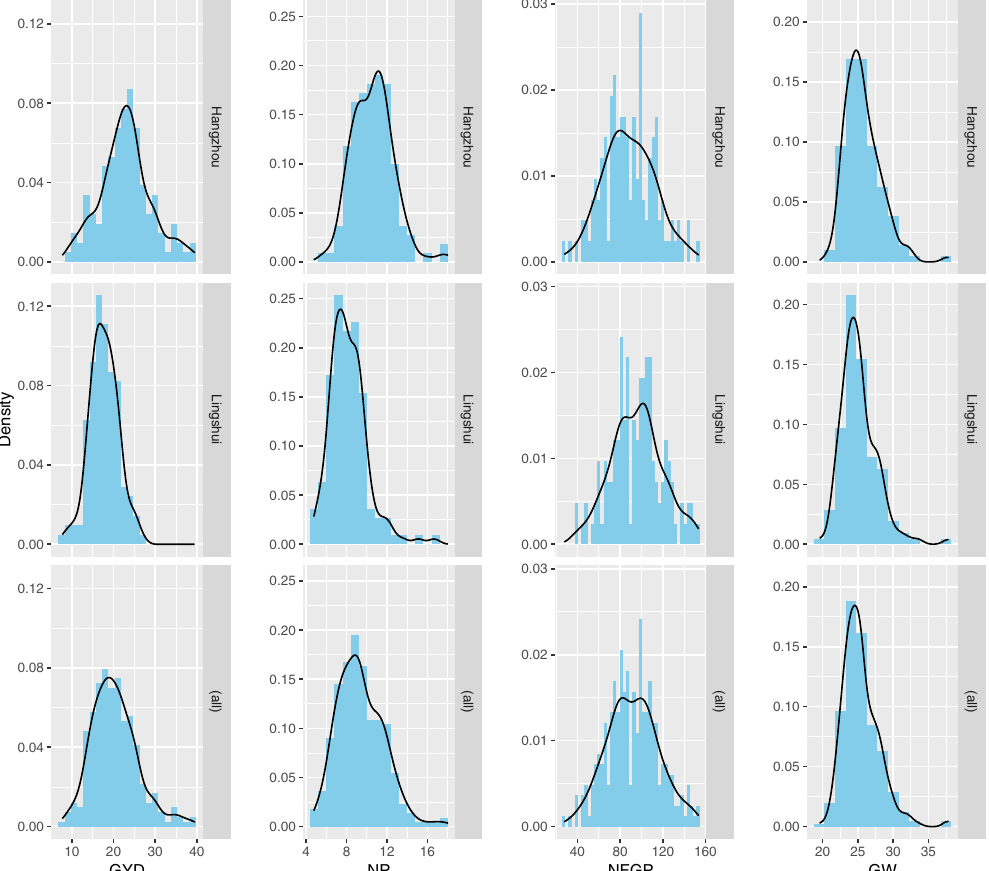
Figure 1. The phenotypic distribution of grain yield and yield components. The histograms for phenotypes from each experiment location Hangzhou (top panel), Lingshui (middle panel), and their together (bottom panel) were plotted; and each column represents one phenotype (from left to right: grain yield (GYD), number of panicles (NP), number of filled grains per panicle (NFGP), grain weight (GW)).